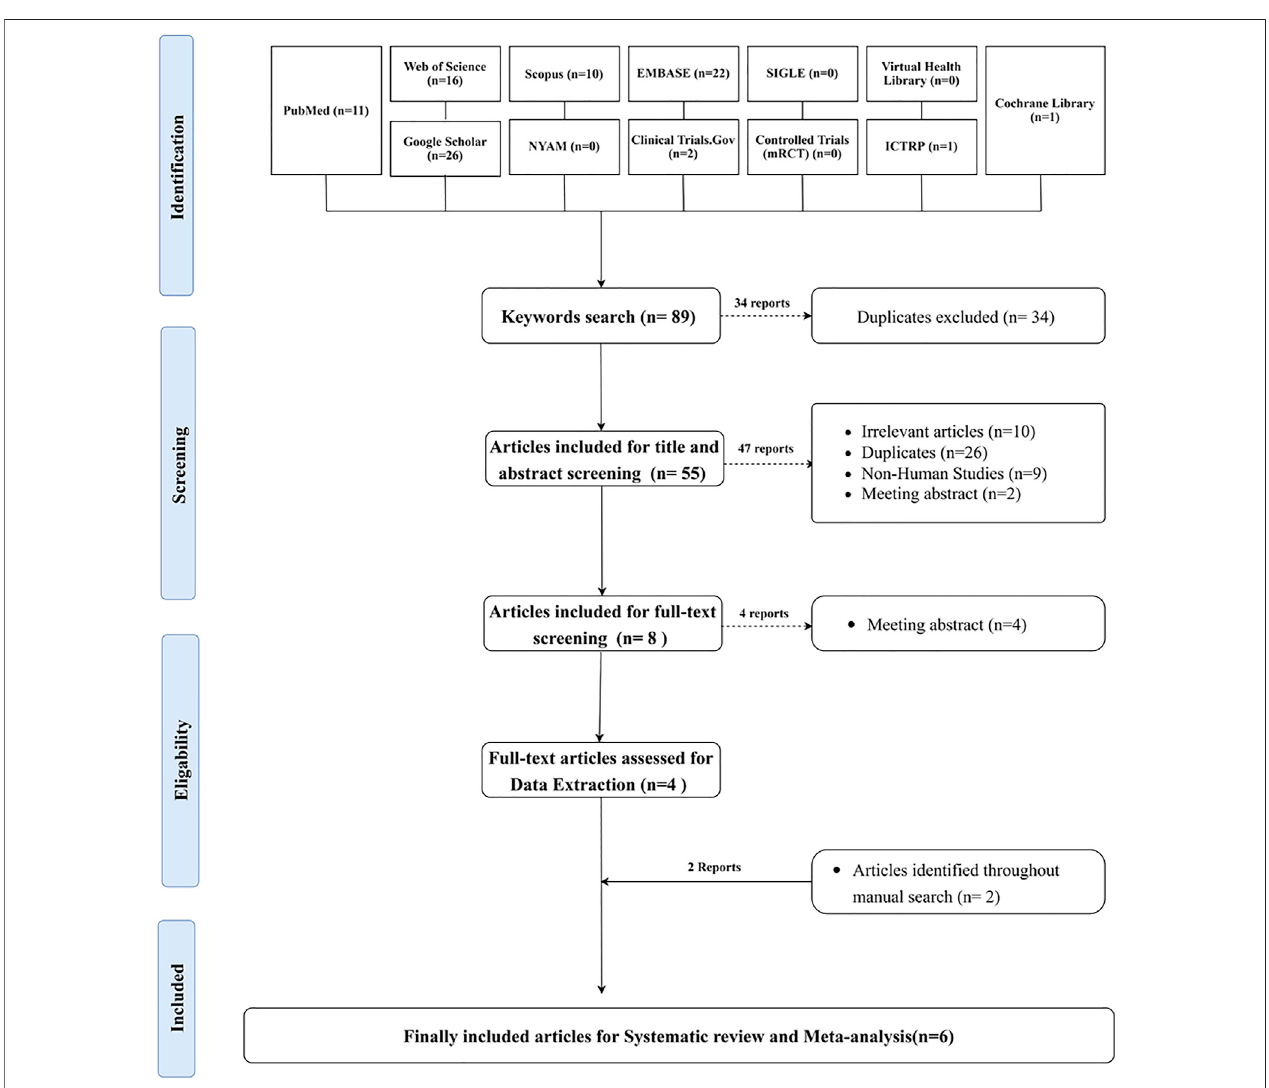
FIGURE 1 | PRISMA fl owchart depicting the process of doing a literature search, screening titles, abstracts, and full texts, conducting a systematic review, and conducting a meta-analysis.